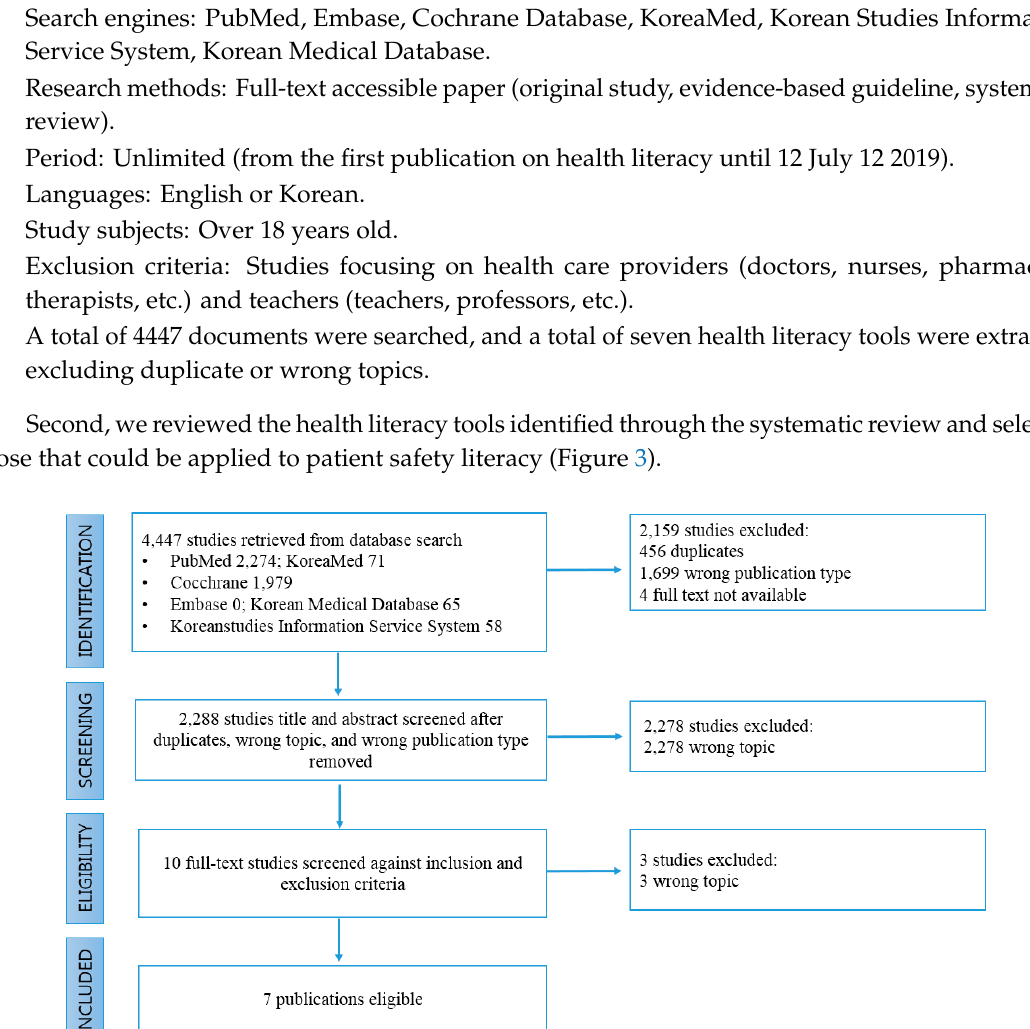
Table 1. Results of evaluation of studies by seven researchers.